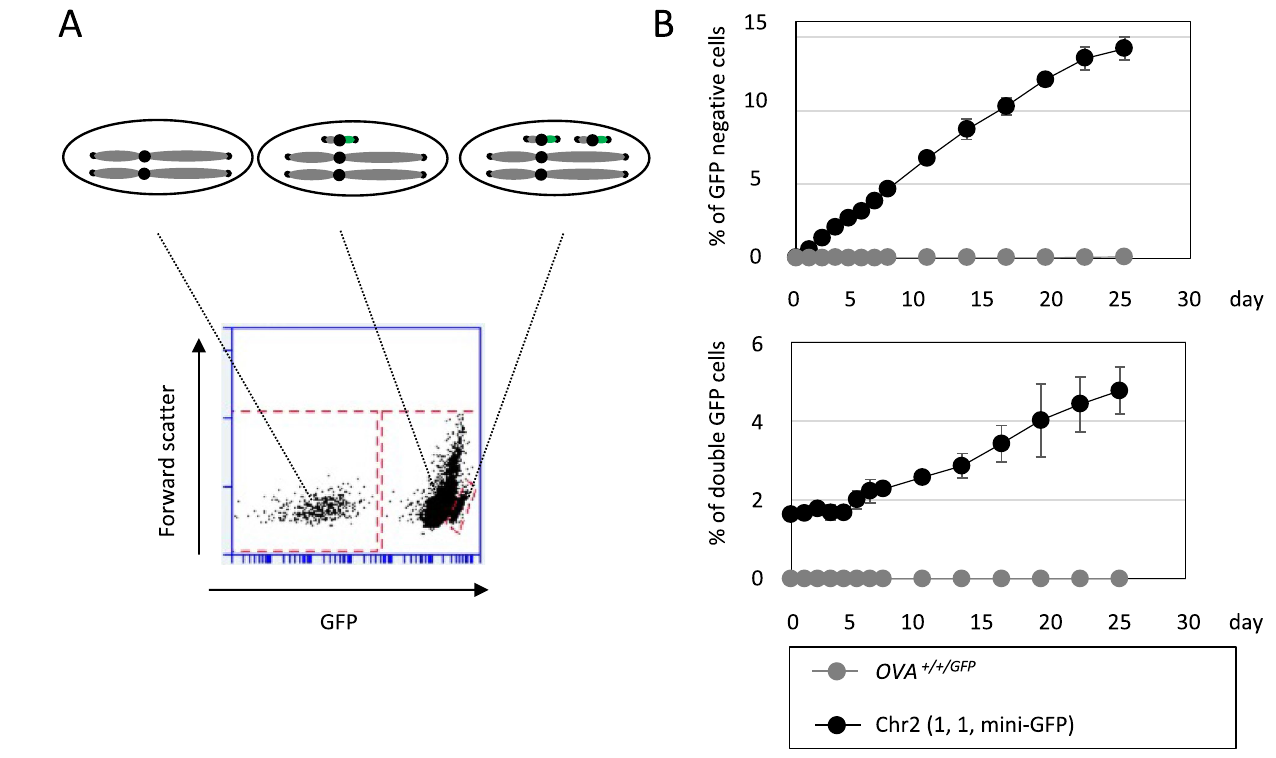
Figure 5. The stability of mini-chromosome. ( A ) Representative result of FACS analysis to detect the copy number of mini-chromosome. ( B ) DT40 Chr2 (1, 1, mini-GFP) and Chr2 (1, 1, 1-GFP) cells were preincubated with puromycin for 24 h to remove cells without GFP and puroR genes. Then, puromycin was washed out, and the cells were cultured for 25 days. The percentage of GFP negative and double GFP cells was analyzed by flow cytometer at indicated time points. Error bars show the SD of the mean for 3 independent